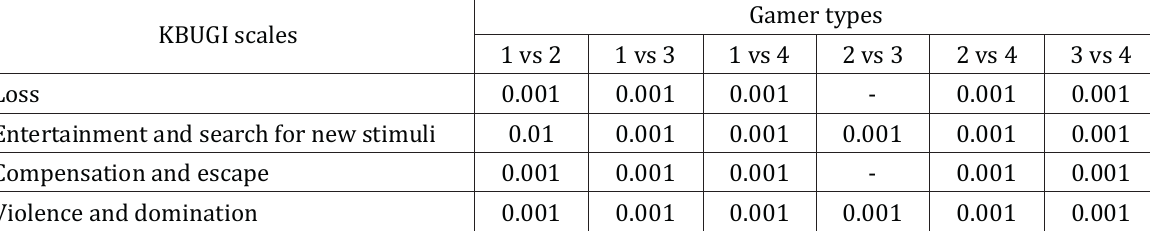
Table 2. Level of significance of differences between pairs of types of young online gamers on KBUGI